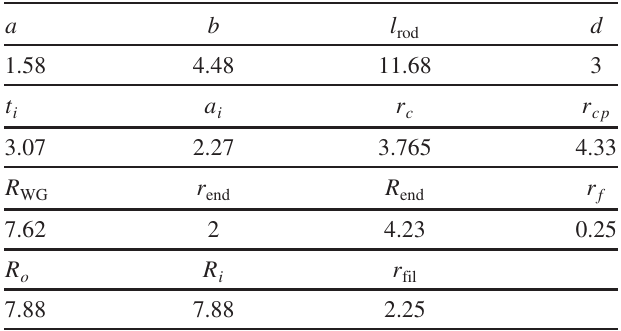
TABLE II. Values of the design parameters of the HPBG-d3 structure (unit: